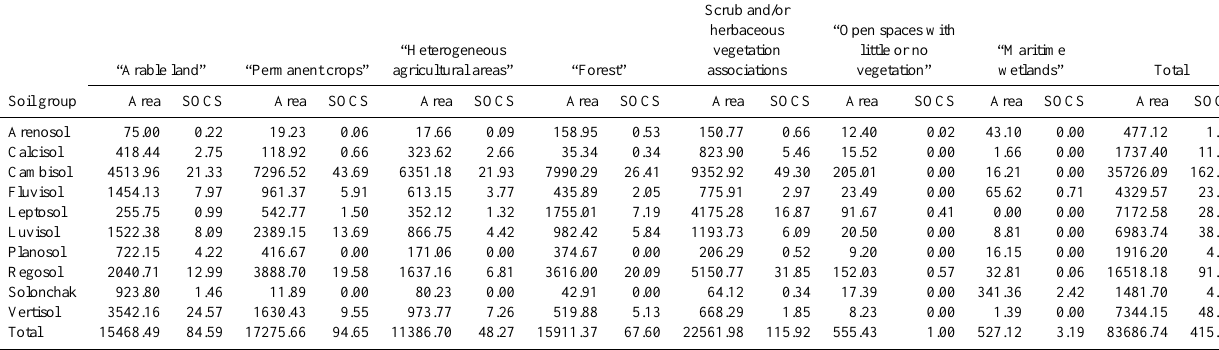
Table 1. Area (km 2 ) and SOC stocks (SOC stock, Tg) under main land uses types and soil groups.